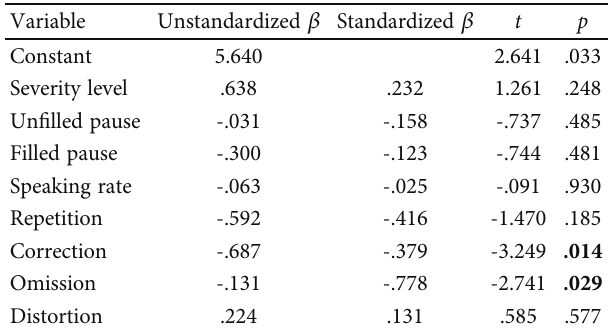
Table 4: Contributions of severity level and each of the fl uency